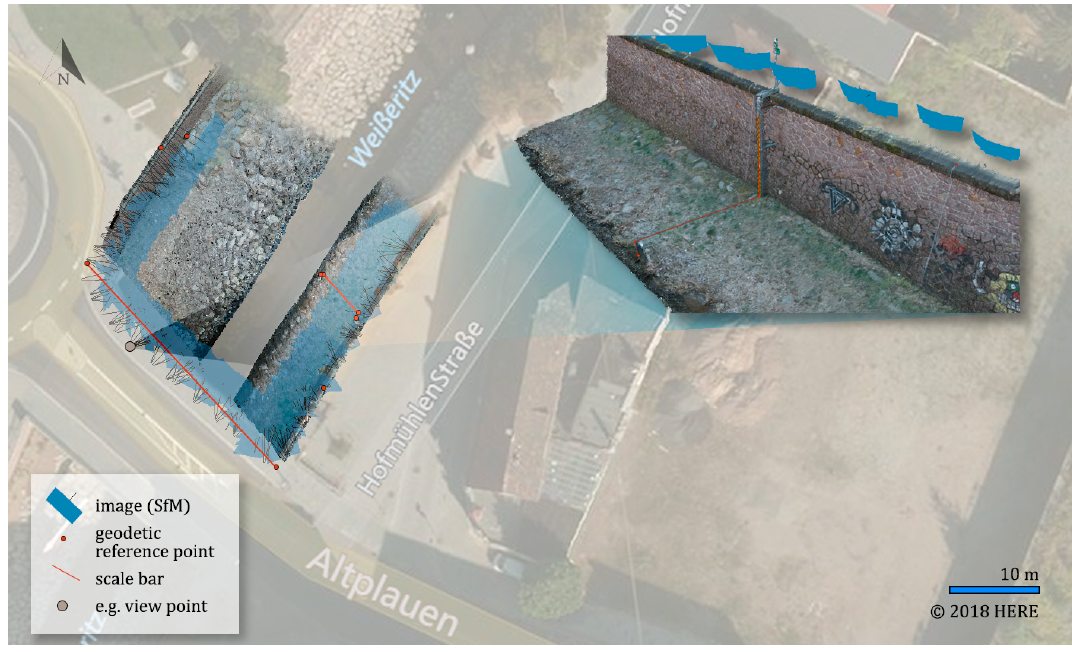
Figure 2. Study region Weißeritz in Dresden, Altplauen: SfM configuration with 3D point cloud overlay (left) and detail shot (right) close to a official